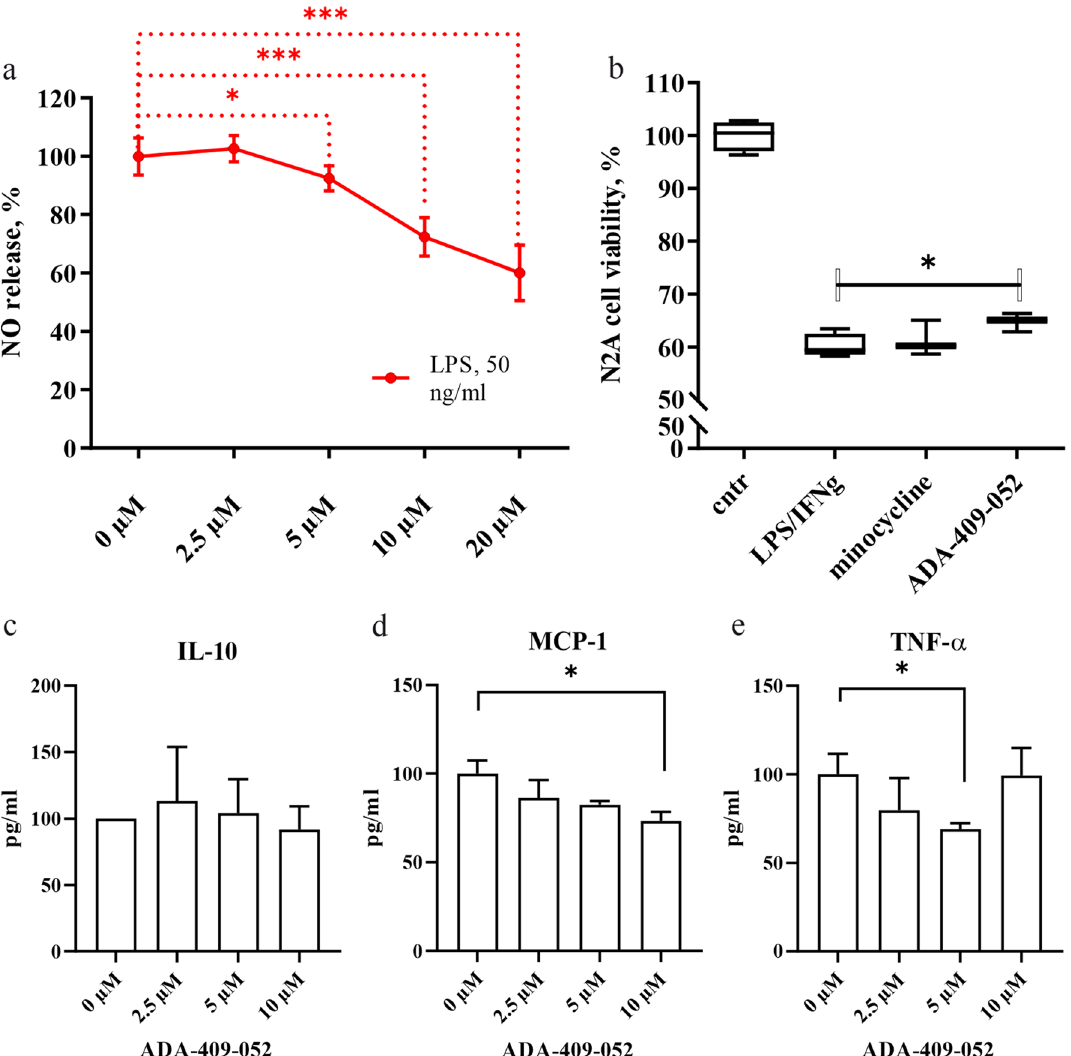
Figure 4. (a) ADA-409-052 inhibits LPS-induced inflammation in BV2 microglial-like cells. The addition of 5, 10, and 20 µM ADA-409-052 significantly attenuated the release of NO, measured from the media of LPS- exposed BV2 cells using the Griess reagent, when compared to cells treated with LPS only. Data are represented as percentages of NO-release after normalization to LPS-stimulated BV2 cells ± s.e.m.; unpaired, two-tailed student’s t-test; technical n = 6; *p < 0.05, ***p < 0.0001. ( b) ADA-409-052 protects N2a neuronal cells when co-cultured with LPS-stimulated RAW 264.7 macrophages. Boxplots show that LPS and INF-γ treatment of co-cultured N2a cells and RAW 264.7 macrophages decreased the viability of N2a cells about 40% as detected by the CytoFLEX S (Beckman Coulter) as a fraction of CD11b negative (CD11b - ), PI negative (PI - ), surviving cells to the total number of gated cells, normalized to the control sample. Co-treatment of ADA-409-052 and LPS/INF-γ resulted in a significant increase of the N2a cell viability, detected by the reduced percentage of CD11b - / PI positive (PI + , dead) cells when compared to LPS/INF-γ treatment only. In contrast, the proportion of CD11b - /PI + N2a cells remained unaltered by minocycline. Cell survival is displayed as individual boxplot per treatment with interquartile range, whiskers set from min to max; unpaired, two-tailed student’s t-test; technical n = 3/4; *p = 0.0314. ( c–e ) ADA-409-052 alters the expression of pro- and anti-inflammatory cytokine expression of BV2 microglial cells. By measuring cytokine-secretion of ADA-409-052-stimulated BV2 cells, using the BD CBA mouse inflammation kit, (c) no changes in secretion of the anti-inflammatory IL-10 were detected. (d) However, we detected a major decrease of MCP-1 upon the addition of 10 µM ADA-409-052. (e) Furthermore, TNF-α decreased upon ADA-409-052-stimulation (5 µM) significantly when compared with untreated cells (0 µM ADA-409-052). Student’s t-test, n = 4; *p <